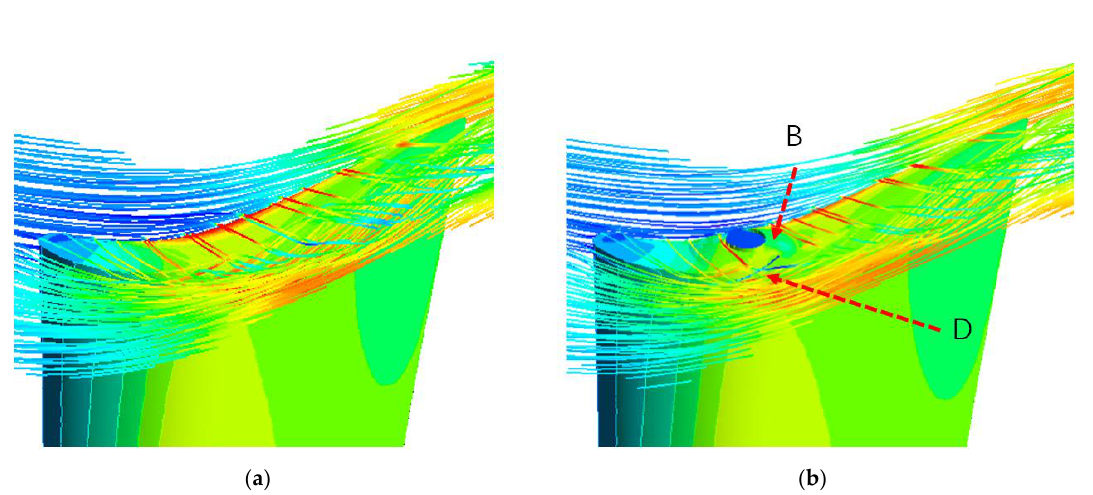
Figure 6. Streamlines near the tip region at design angle. ( a ) Datum ( b ) Convex.